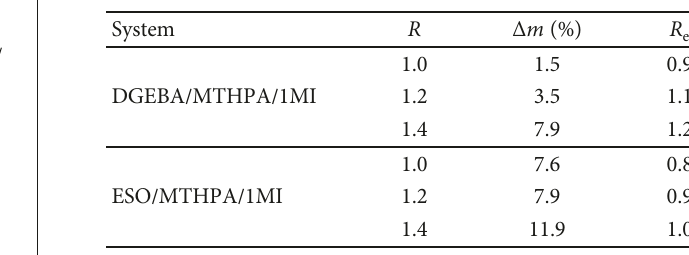
Table 4: Mass percentage evaporated during the dynamic curing for the DGEBA/MTHPA/1MI and ESO/MTHPA/1MI systems with di ff erent stoichiometric ratios R